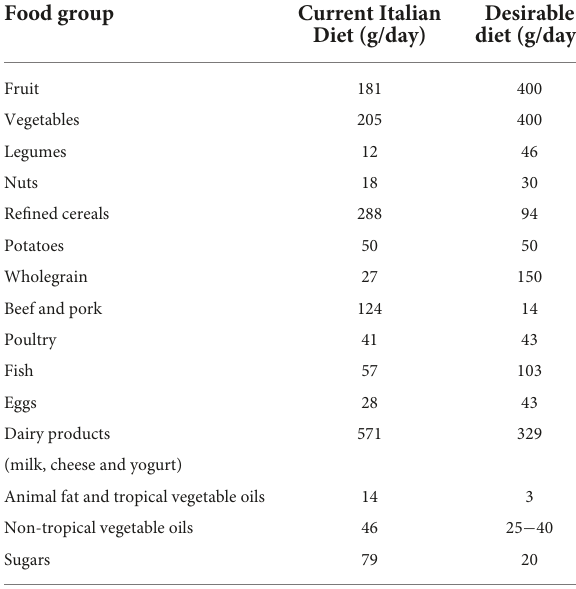
TABLE 1 Daily average consumption of the various food groups in the desirable and the current Italian diet (Source: Authors). Food